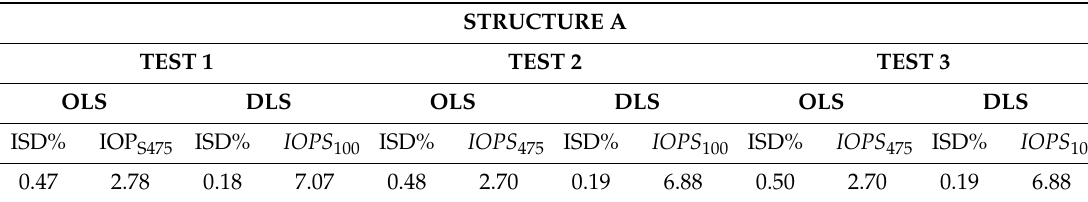
Table 12. Maximum Interstory Drift (ISD) % and operativity indicators IOPS 475 and IOPS 100 for Operating Limit State (OLS) and Damage Limit State (DLS).